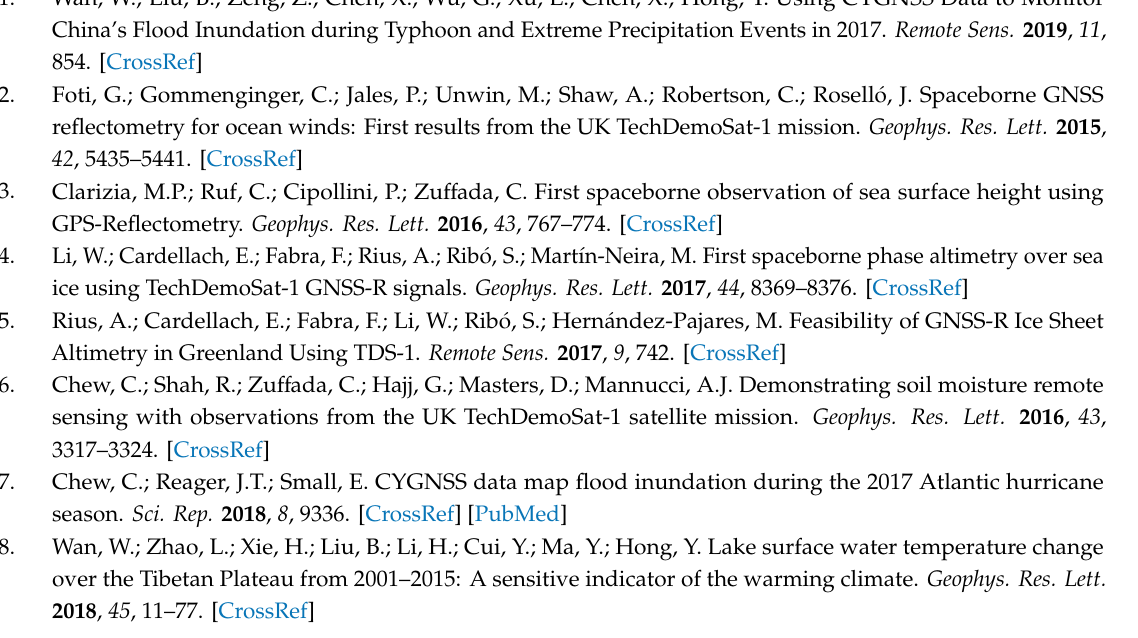
Table S1: Hydroweb data source of the water levels for lakes used in this